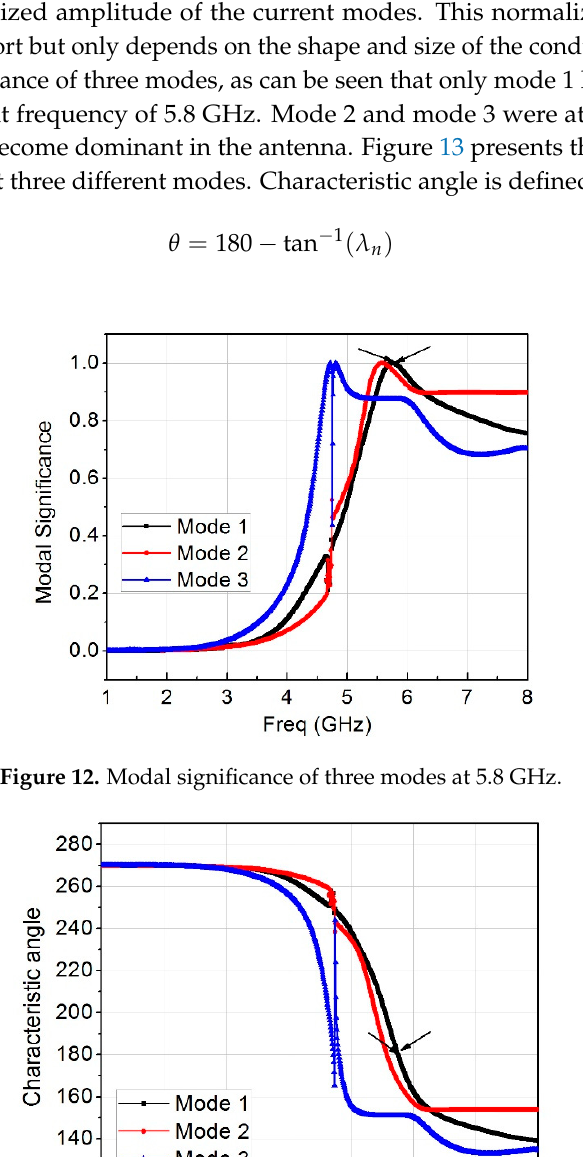
Figure 14. Eigenvalues of three modes at 5.8 GHz.